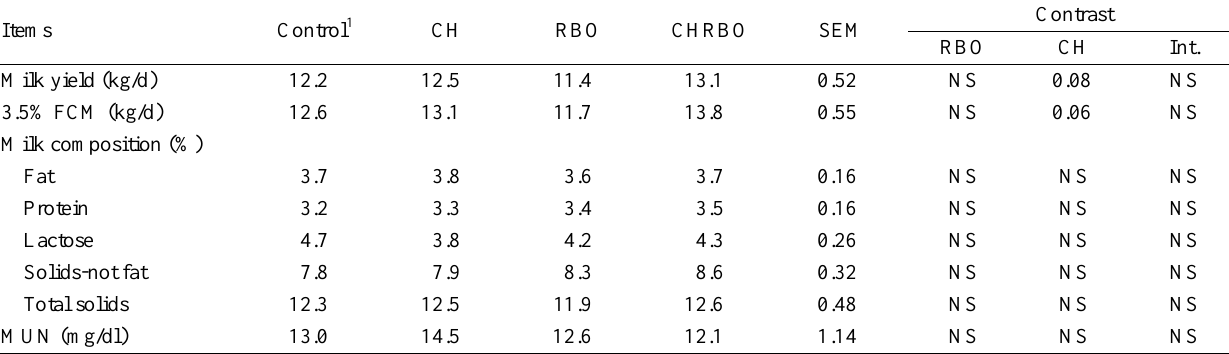
Table 6. Effect of cassava hay and rice bran oil on milk yield and milk composition in lactating dairy cows Items Control 1 CH RBO CHRBO